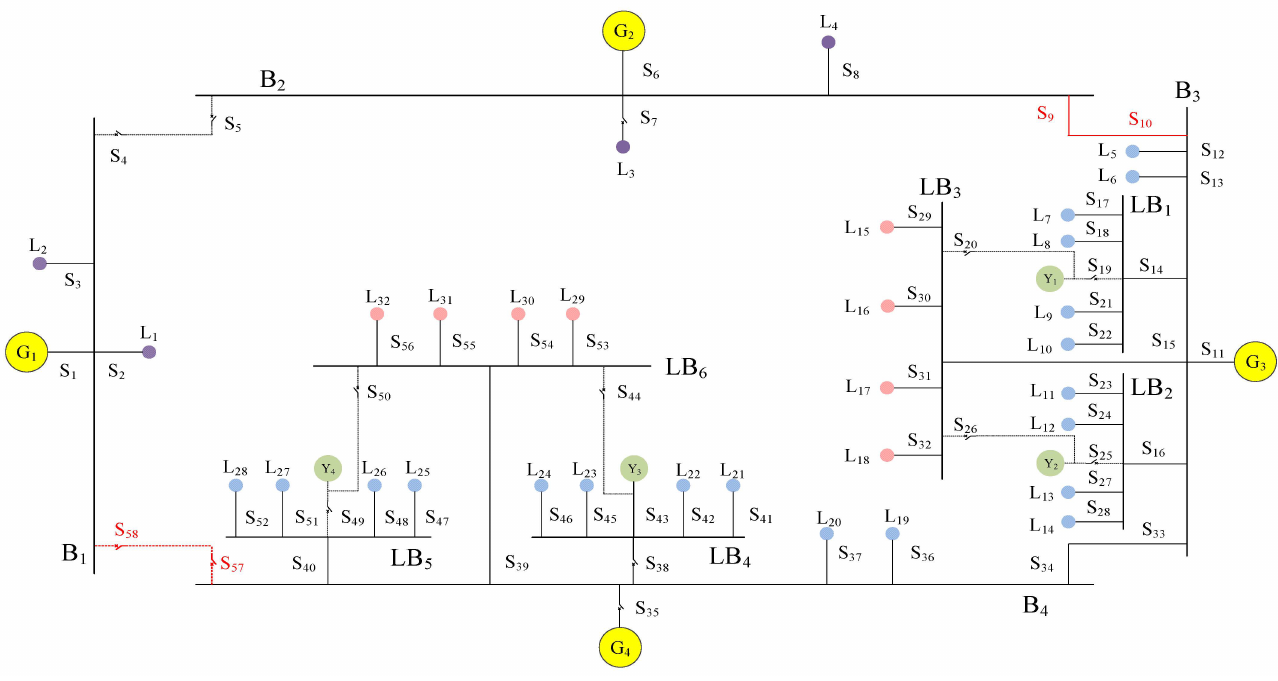
Figure 14. The revised system topology under fault scenario